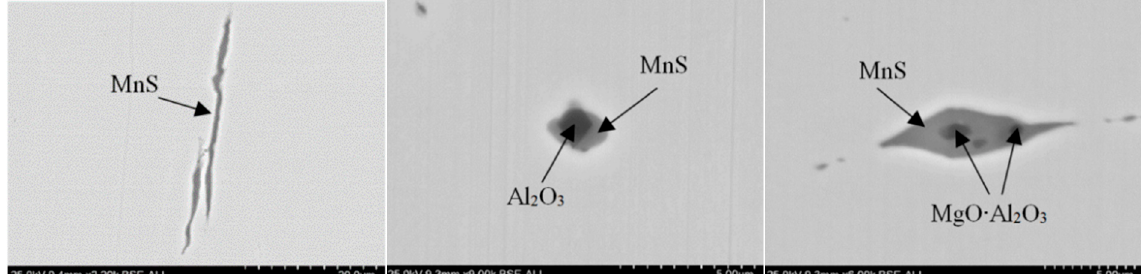
Figure 6. SEM morphologies of elongated and spindle-shaped MnS in rolled steel samples.